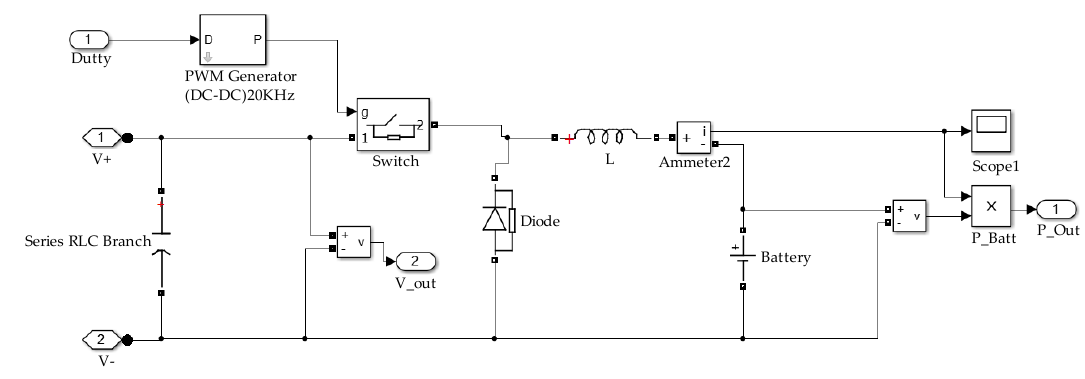
Figure 6. Buck converter modeled in Simulink.